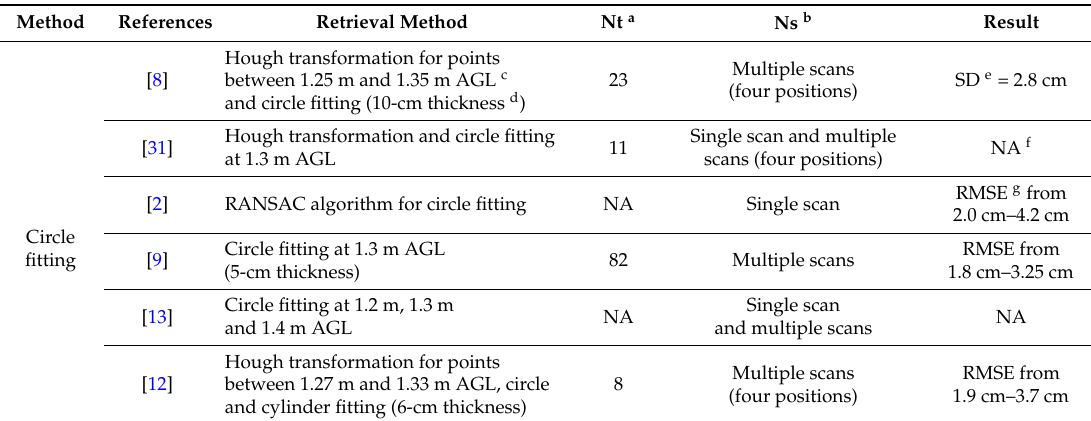
Table 1. Overview of diameter retrieval methods using TLS and their